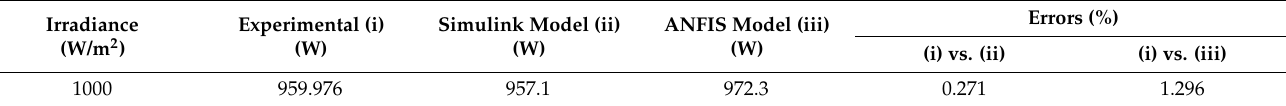
Table 4. Power comparison between experimental results, Simulink model, and ANFIS model.